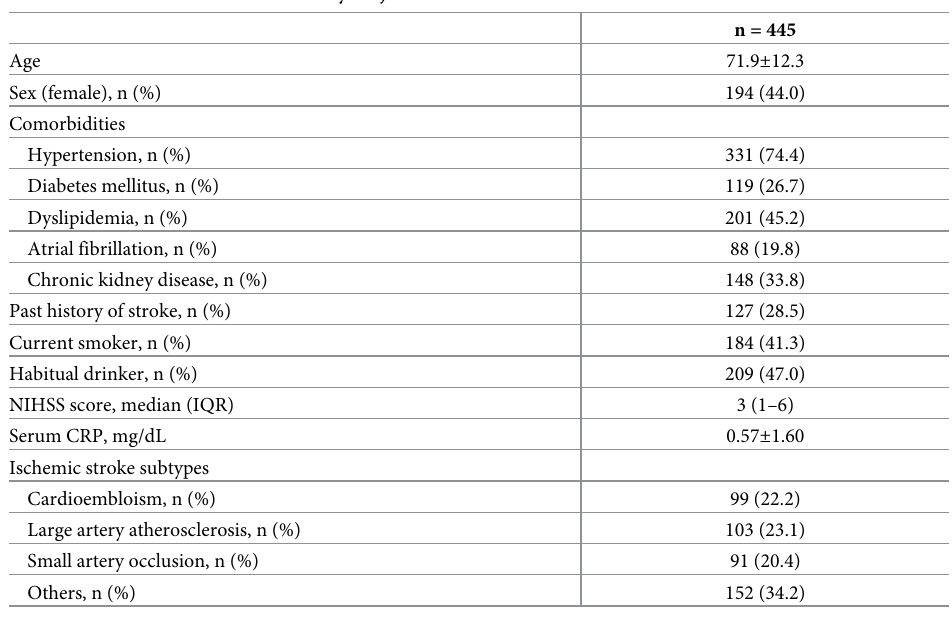
Table 1. Baseline characteristics of study